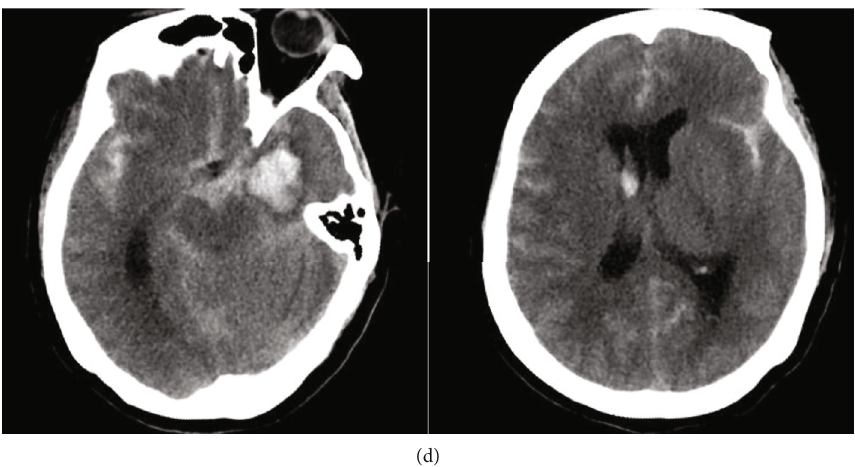
Figure 1: The mFS, a CT-based rating scale is as follows; (a) Grade 1 consists of thin, minimal, or di ff use SAH without IVH; (b) Grade 2 consists of minimal or thin SAH with IVH; (c) Grade 3 is de fi ned by a thick cisternal clot without IVH; (d) Grade 4 is de fi ned by a cisternal clot with IVH. Abbreviations: CT: computed tomography; IVH: intraventricular hemorrhage; mFS: modi fi ed Fisher scale; SAH: subarachnoid